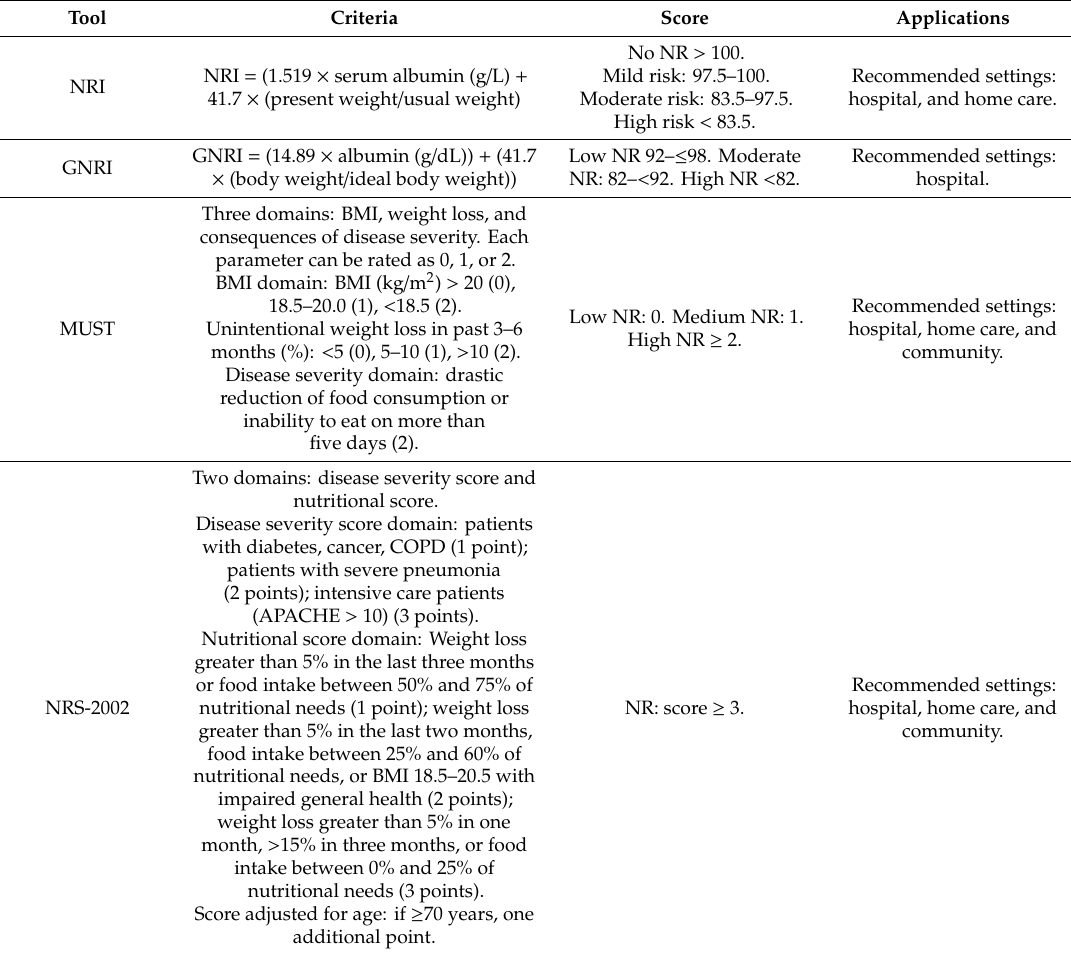
Table 4. Parameters of nutritional screening tools used in the included studies. Tool Criteria Score